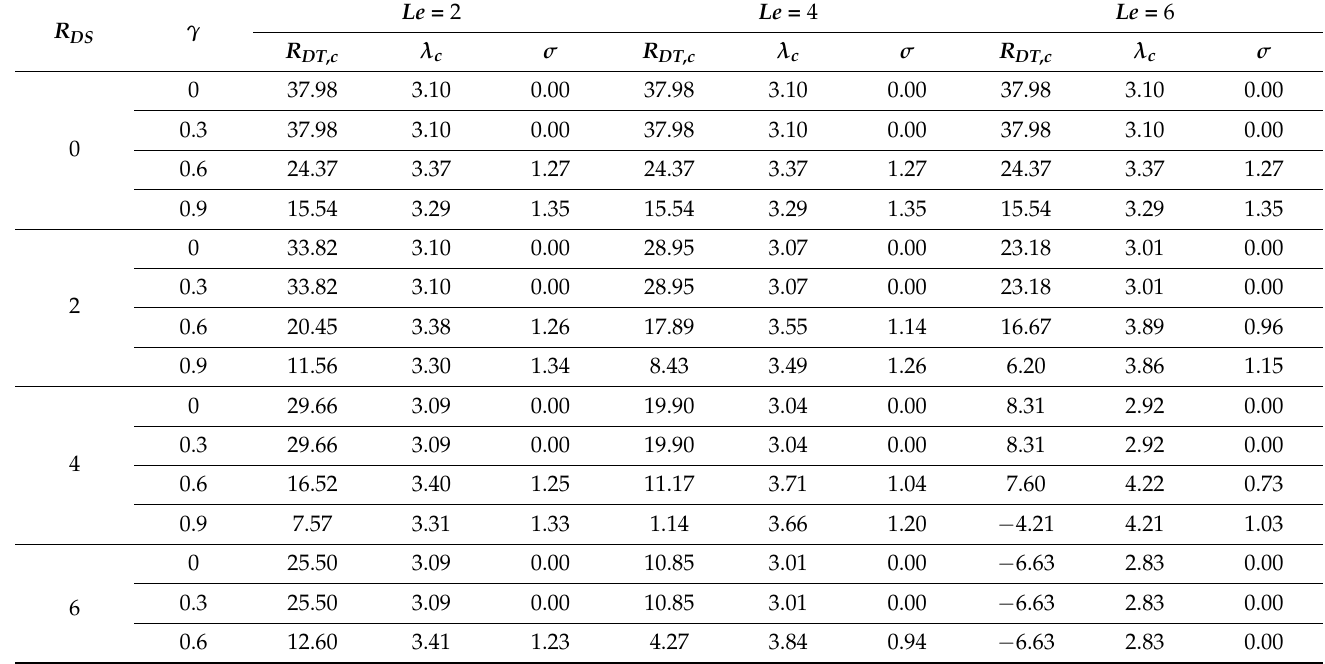
Table 2. Comparison of R DT , c , λ c , and σ for diverse values of γ , R DS , and Le at Le = 2, m =